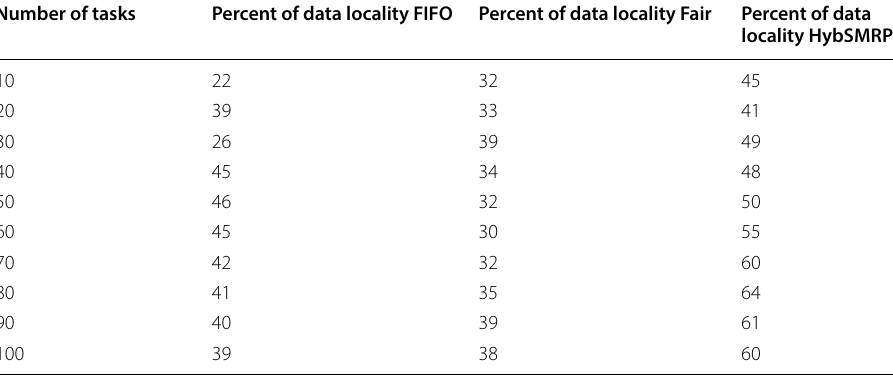
Table 5 Numerical comparison of HybSMRP with FIFO and Fair schedulers based on data locality rate on Terasort Number of